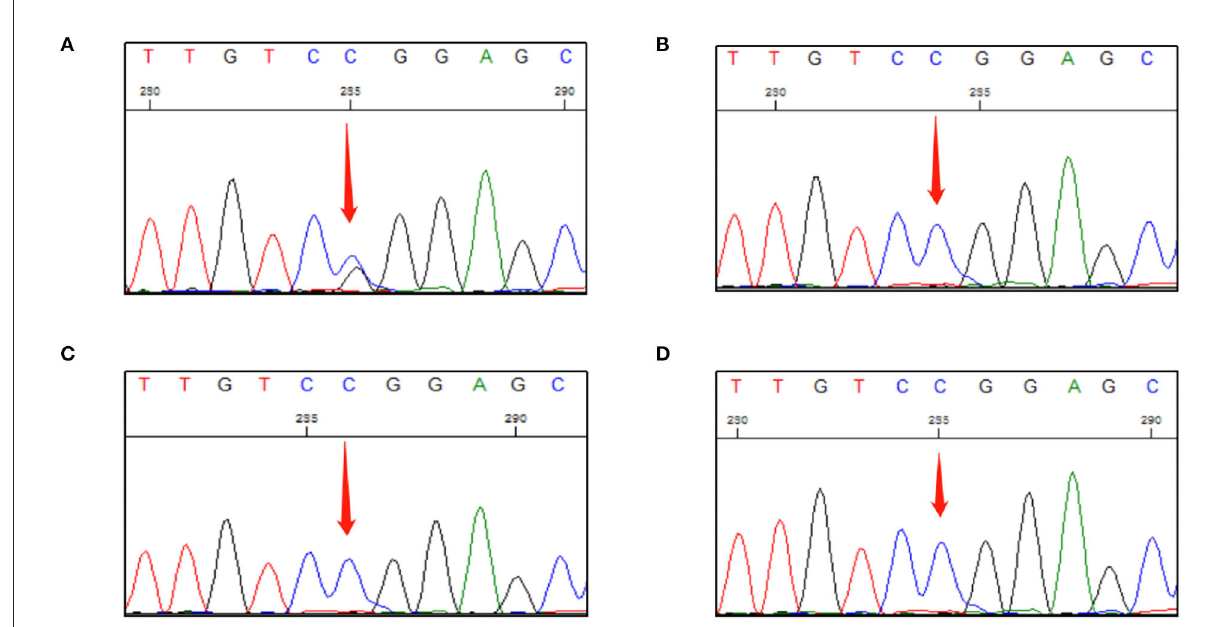
FIGURE2 First-generation sequencing peak diagram. (A) The proband carried a heterozygous variant at the VHL c.499C > G site. (B) The proband’s daughter did not carry this heterozygous mutation. (C) The proband’s son did not carry this heterozygous mutation. (D) The proband’s only younger brother did not carry this heterozygous